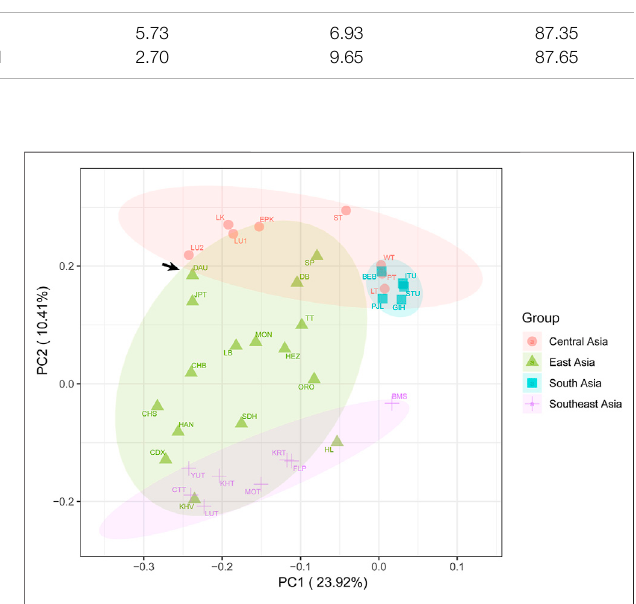
FIGURE 5 | The principal component analysis (PCA) plot for the Daur group and 56 worldwide populations. Daur belongs to the East Asian cluster, indicated in dark green.